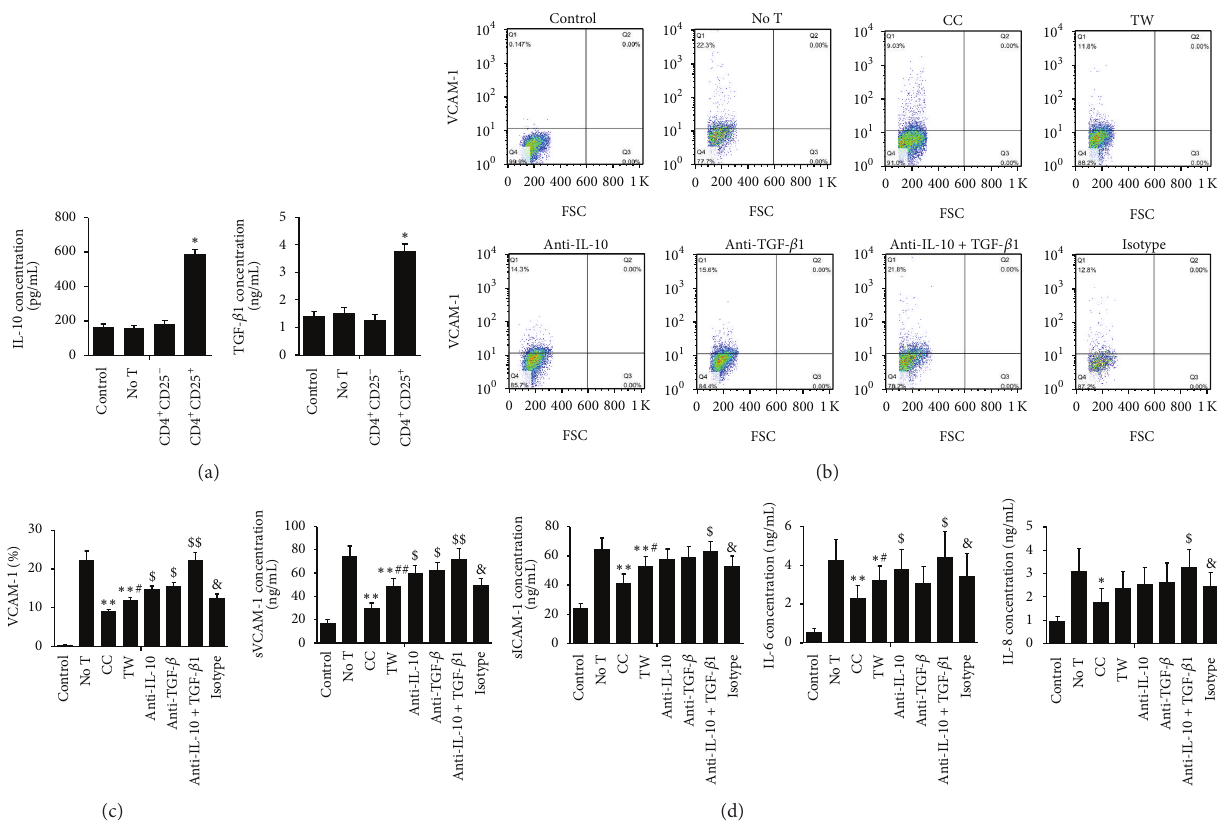
Figure 9: The mechanisms of Tregs-mediated suppression of HUVECs exposed to PM. HUVECs were cultured without T cells (no T) or with Tregs in the presence of anti-CD3 mAbs in either a coculture (CC) or a TW system. After 48 hours of culture, the inserts were removed and HUVECs in the lower well were stimulated with PM. In some experiments, IL-10, TGF- 𝛽 1, IL- 10+ TGF- 𝛽 1, or isotype mAbs was added to the lower well. The adhesion molecules and cytokines were detected by flow cytometry and Elisa. (a) The concentrations of IL-10 and TGF- 𝛽 1 in the supernatants from different groups. Data are expressed as means ± SEM of 3 independent experiments. ∗ 𝑃 < 0.01 . (b) Dot plots showing the percentages of VCAM-1 expression in HUVECs. (c) The VCAM-1 expression in different groups of HUVECs. (d) The concentration of sVCAM-1, sICAM-1, IL-6, and IL-8 in the supernatants from different groups of HUVECs. Data are expressed as means ± SEM of 4 independent experiments. ∗ indicates CC or TW versus no T; # indicates TW versus CC; $ indicates versus TW; & indicates isotype versus TW. ∗ 𝑃 < 0.05 , ∗∗ 𝑃 < 0.01 , # 𝑃 < 0.05 , ## 𝑃 < 0.01 , $ 𝑃 < 0.05 , $$ 𝑃 < 0.01 , and & 𝑃 > 0.05